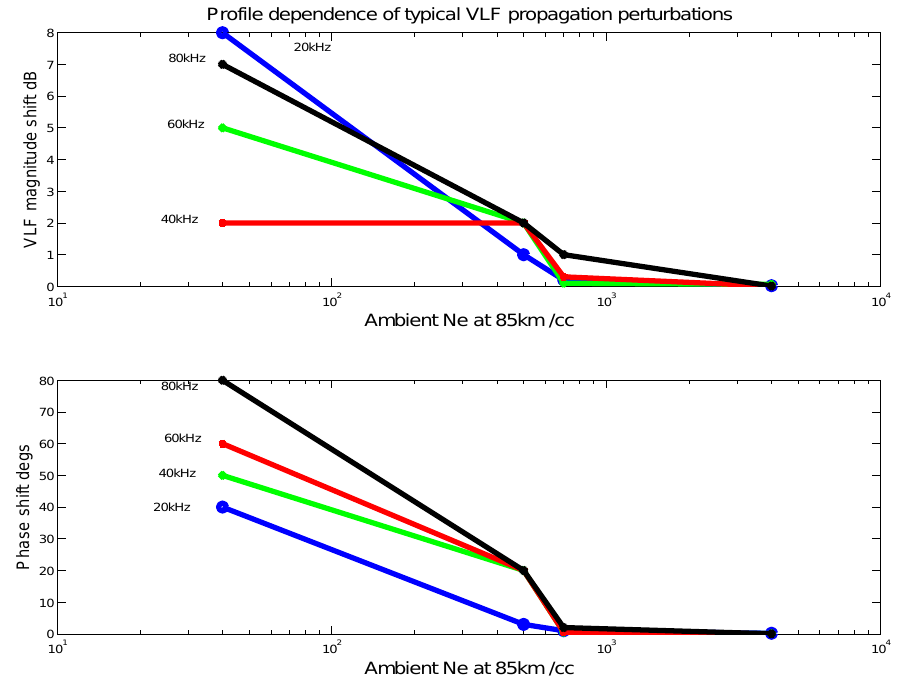
Fig. 11. Variation of the VLF amplitude and phase perturbations with frequency and ambient electron density at 85km. We have utilised median values of the magnitudes of amplitude and phase perturbations at long range. Note the rapid increase as density decreases below 500el/cc. Overall perturbation magnitude increases with frequency.